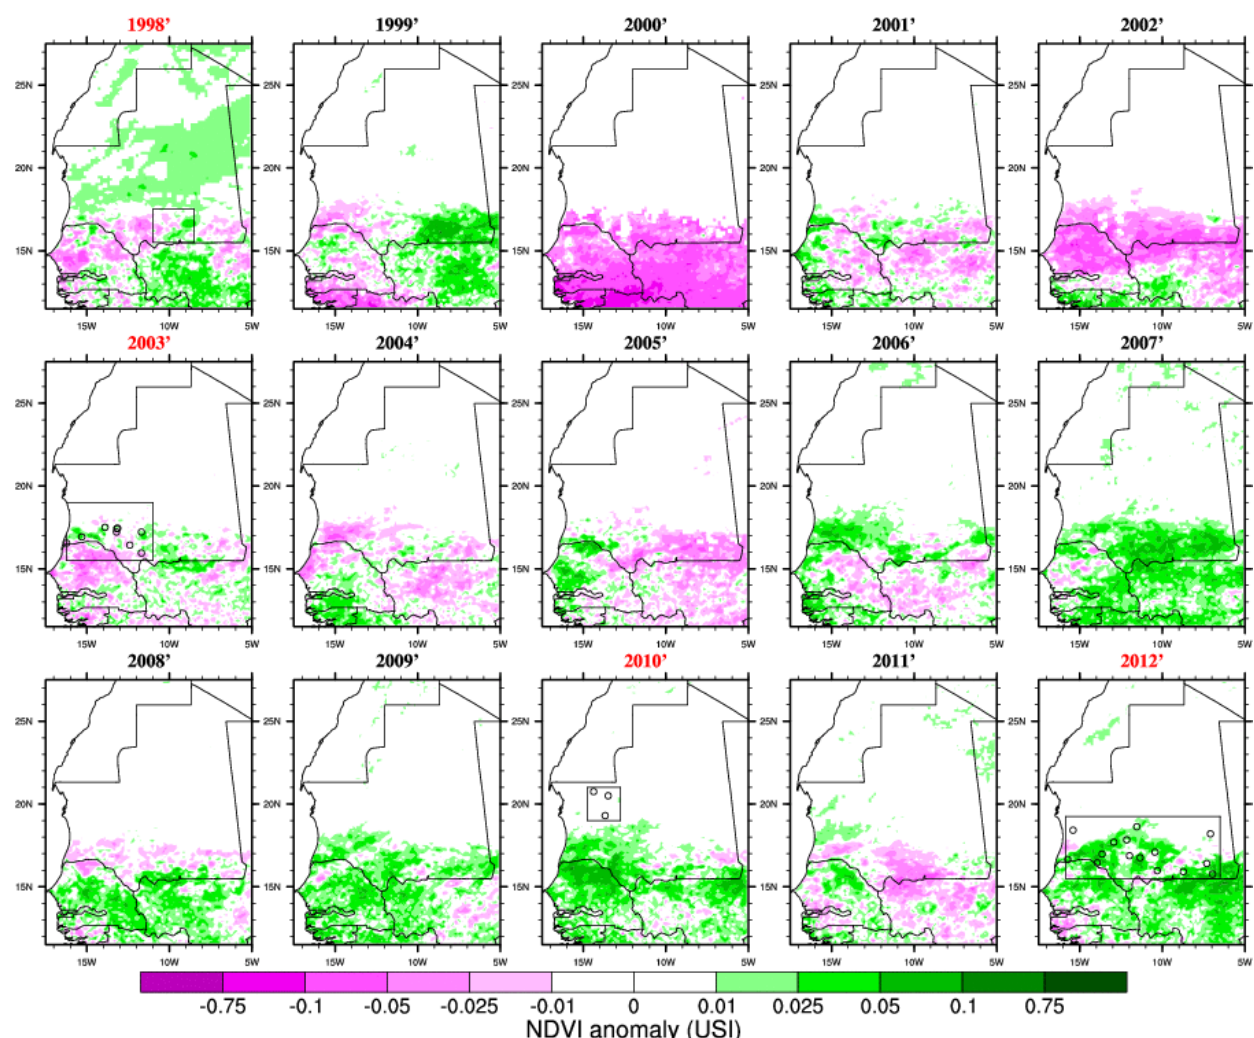
Figure 4. NDVI anomalies (for the season August–September–October–November with respect to the 1998–2012 climatology) based on the GVIX NOAA satellite dataset. Outbreak years are highlighted in red and the locations of reported infections are shown by